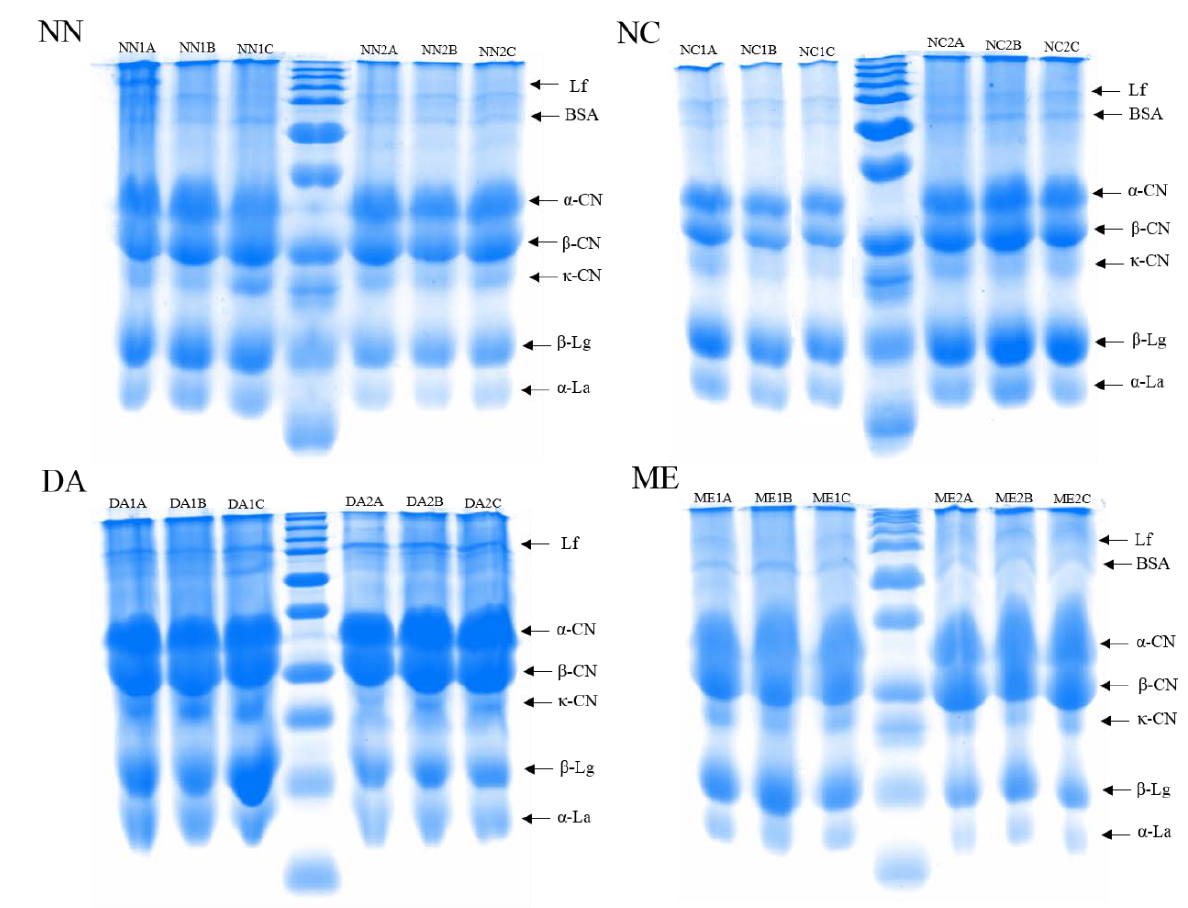
Figure 2. Protein profile of representative infant formulas resolved by SDS-PAGE 12%. Lanes 1, 2 and 3 of each gel represent phase 1 infant formulas (batches A, B and C), the central lanes correspond to Mw markers and lanes 5, 6 and 7 of each gel represent phase 2 infant formulas (batches A, B and C). Lf, lactoferrin; Mw, molecular weight; BSA, bovine serum albumin; α - CN, α - casein; β -CN , β - casein; κ - CN, κ - casein; β - Lg, β - lactoglobulin; α - La, α -lactalbumin. Electrophoresis was run at 200 V and 25 mA for 2 h. Gels were stained with a Coomassie Blue G-250 for 24 h and destained in acetic acid, methanol and distilled water (20:20:60) until the protein bands were visible for photo-documentation.